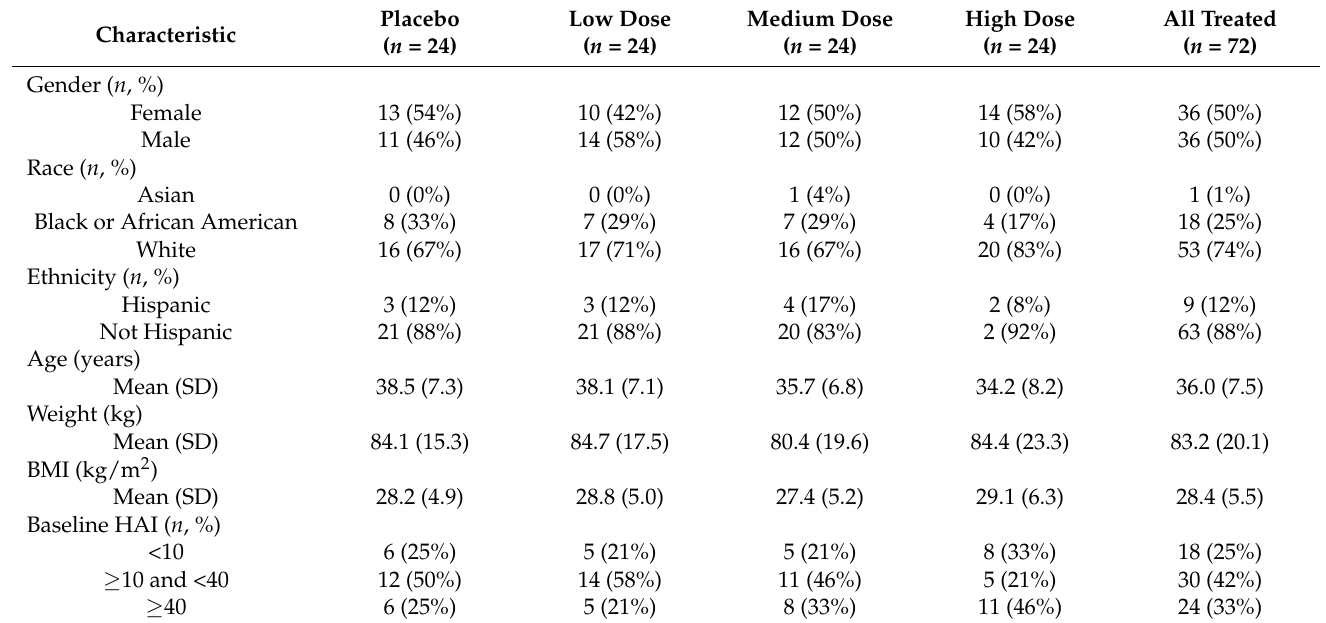
Figure 1. Subject disposition. Vaccine dose (TCID 50 ) groups were 10 6 (low), 10 7 (medium) and 10 8 (high) TCID 50 . Two subjects in each dose group were vaccinated as sentinel subjects before randomization into the group. One vaccinated subject in the medium-dose group was lost to follow up after day 2. Table 1. Baseline characteristics.